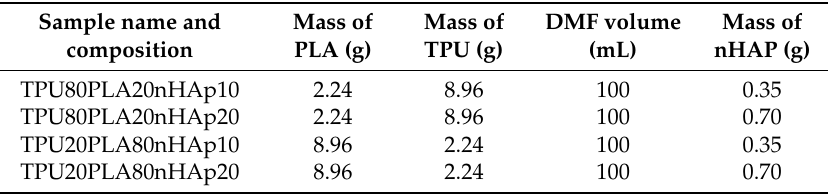
Table 2. Compositions of the porous polymer nanocomposite